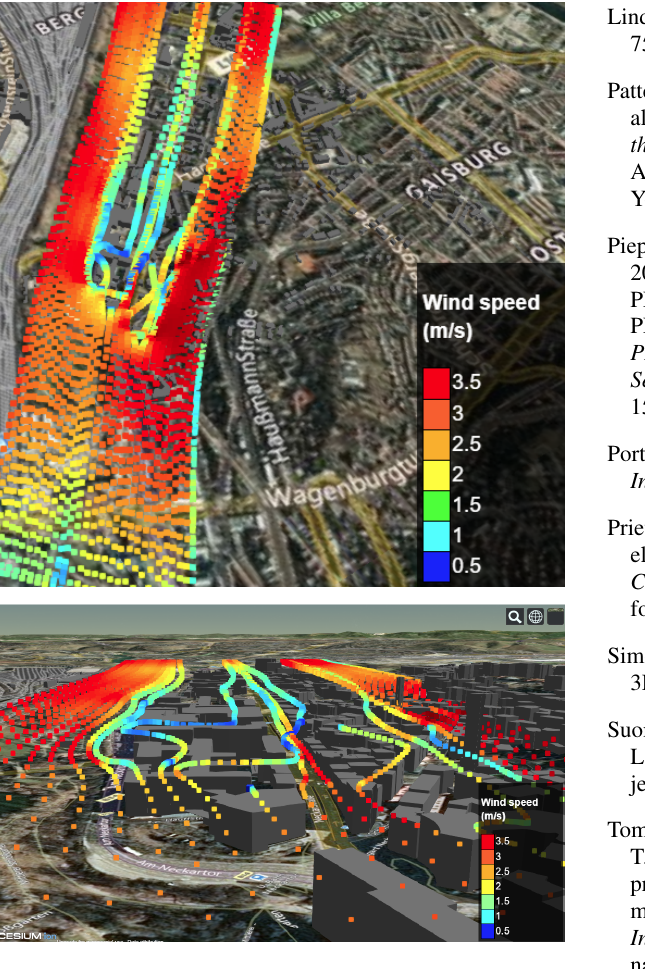
Figure 10. Visualization of streamlines in Cesium. Top: Overview of a city quarter. Bottom: zoomed view on building block. Streamlines are at building height and flow over and around roofs and